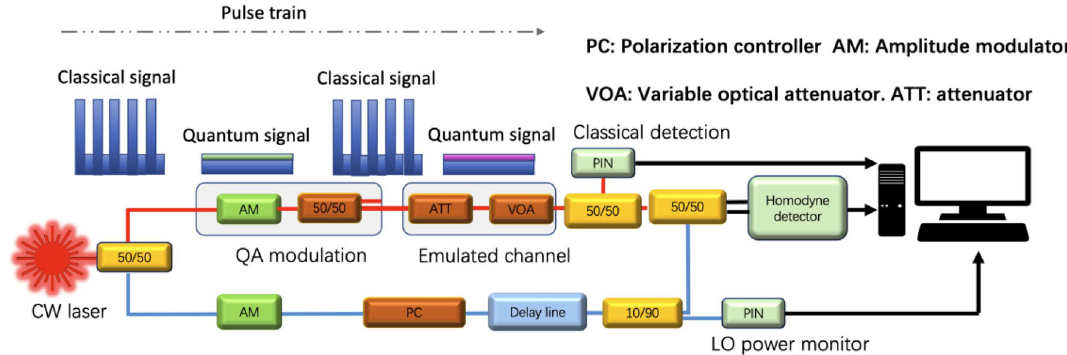
Figure 3. Experimental set-up of the proof-of-principle system. ATT attenuator, VOA variable optical attenuator, AM amplitude modulator, PC polarization controller, PIN photodiode, 50/50: 50:50 fibre